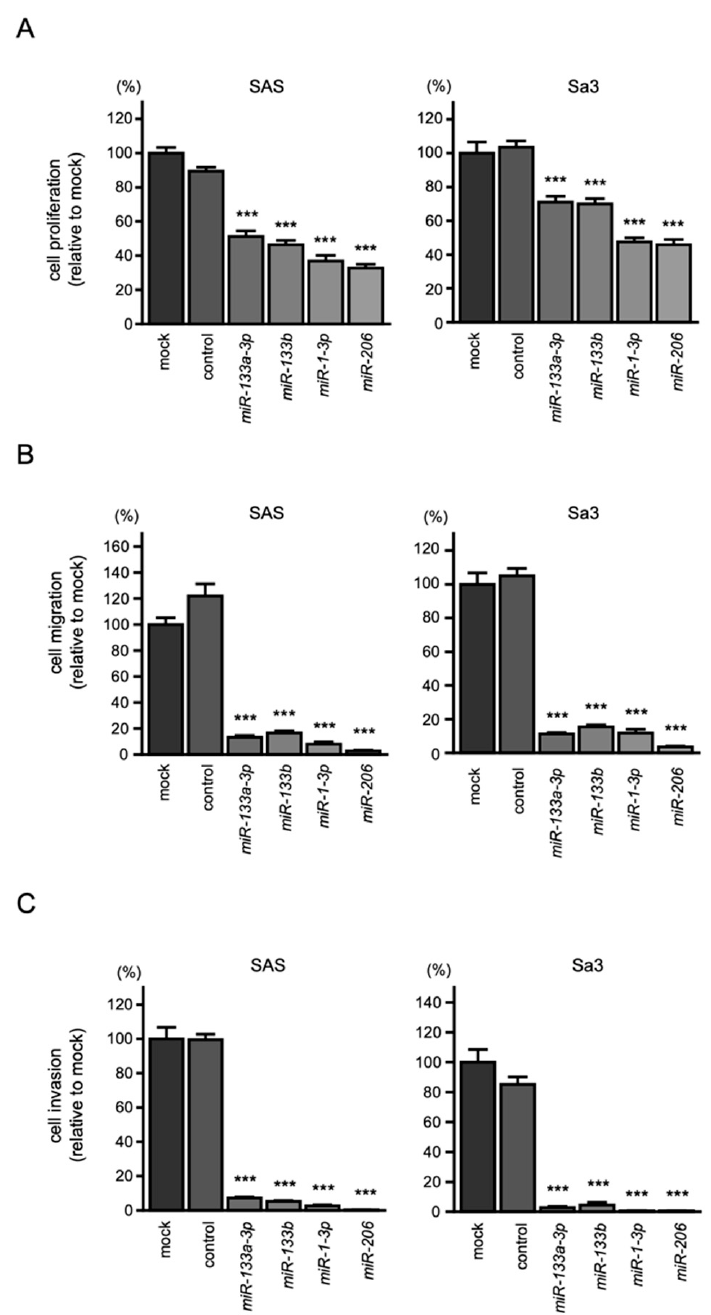
Figure 2. Tumor-suppressive functions of miR-1 / miR-133 clustered miRNAs in HNSCC cells, SAS, and Sa3: ( A ) cell proliferation assays; ( B ) cell migration assays; ( C ) cell invasion assays. (*** p < 0.001). These findings showed tumor suppressive functions of miR-133a-3p / miR-133b and miR-1-3p / miR-206 in